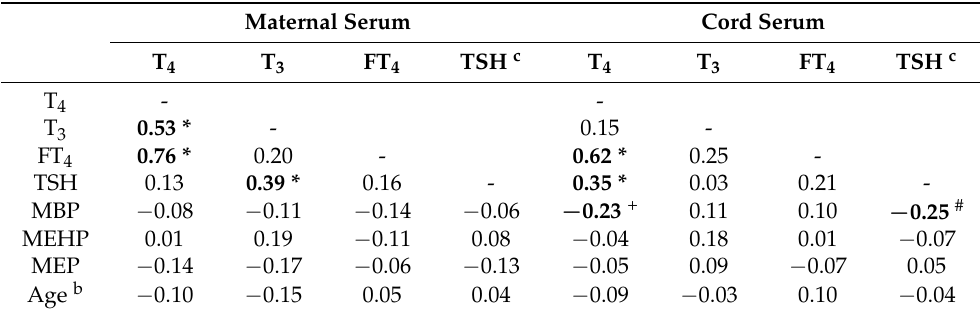
Table 4. Spearman correlation coefficients between thyroid hormones and phthalate monoesters in serum samples ( n = 60) a .